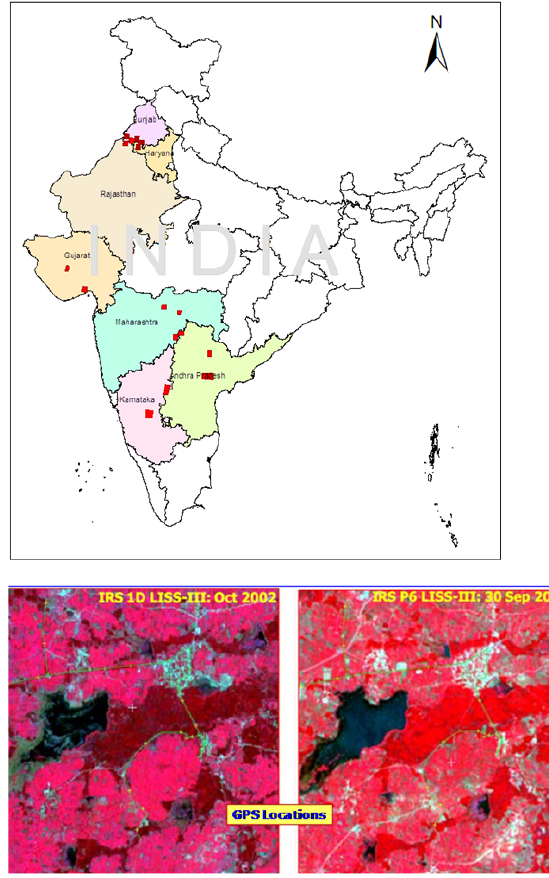
Figure 1. Location map of study areas in major cotton growing zones of